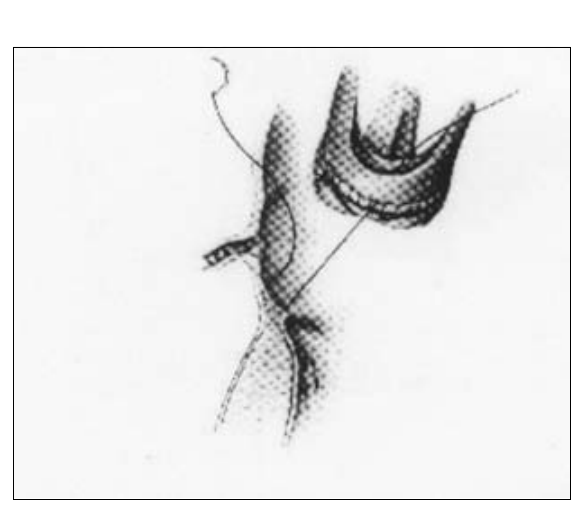
Fig. 4 - Linha de sutura œnica exteriorizada e amarrada no topo dos postes comissurais (reproduzida com permissªo do Dr. Mark F.